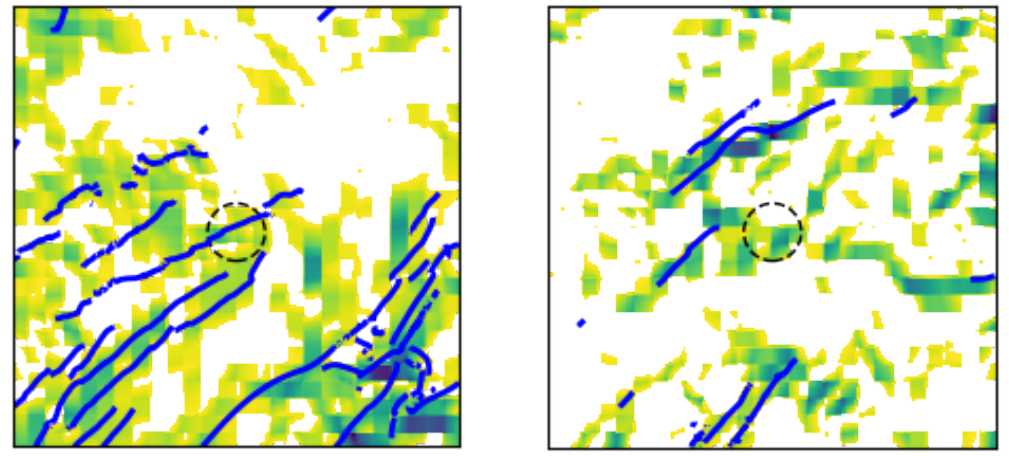
Figure 10. Depiction of a true positive ( left ) and a false positive ( right ), from approximately 43.5 h and 20.67 h, respectively. The true attraction rate field over Kentland Farm Va. is displayed; darker greens are lower values of the attraction rate. Grid points where the value of the attraction rate is above the threshold value are masked (white). Attracting LCS with an integration time of − 1 h are shown as blue lines. The threshold radius is shown by the black dashed circle and has a radius of 5 km. In both